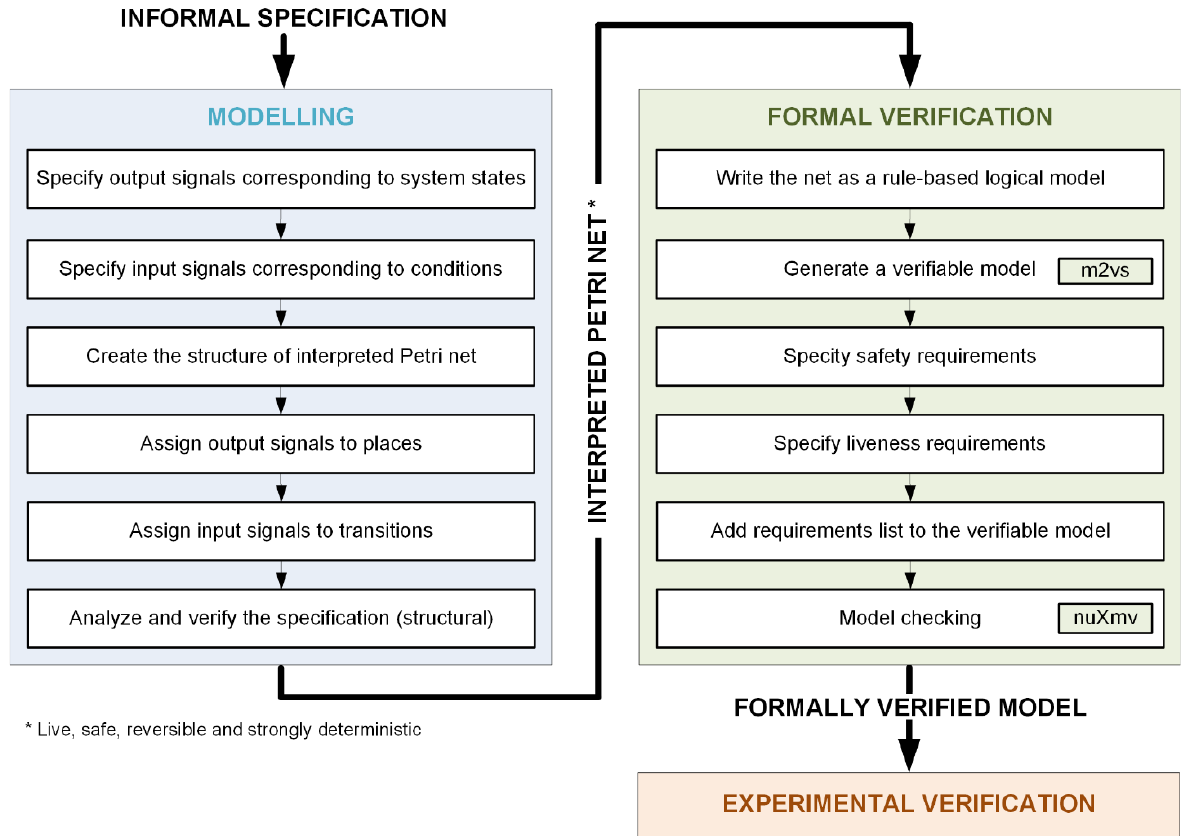
Figure 2. The schema of the proposed modelling and verification